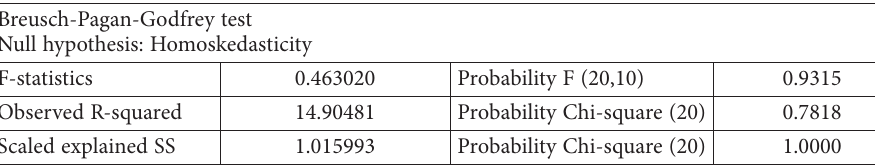
Breusch-Pagan-Godfrey test Null hypothesis: